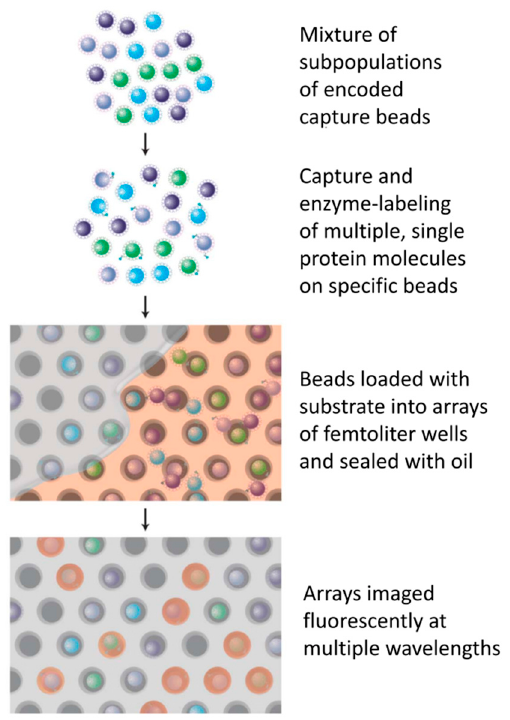
Figure 2. Schematic of multiplexed digital ELISA process. Reprinted with permission from [33]. Copyright 2013 Royal Society of Chemistry.